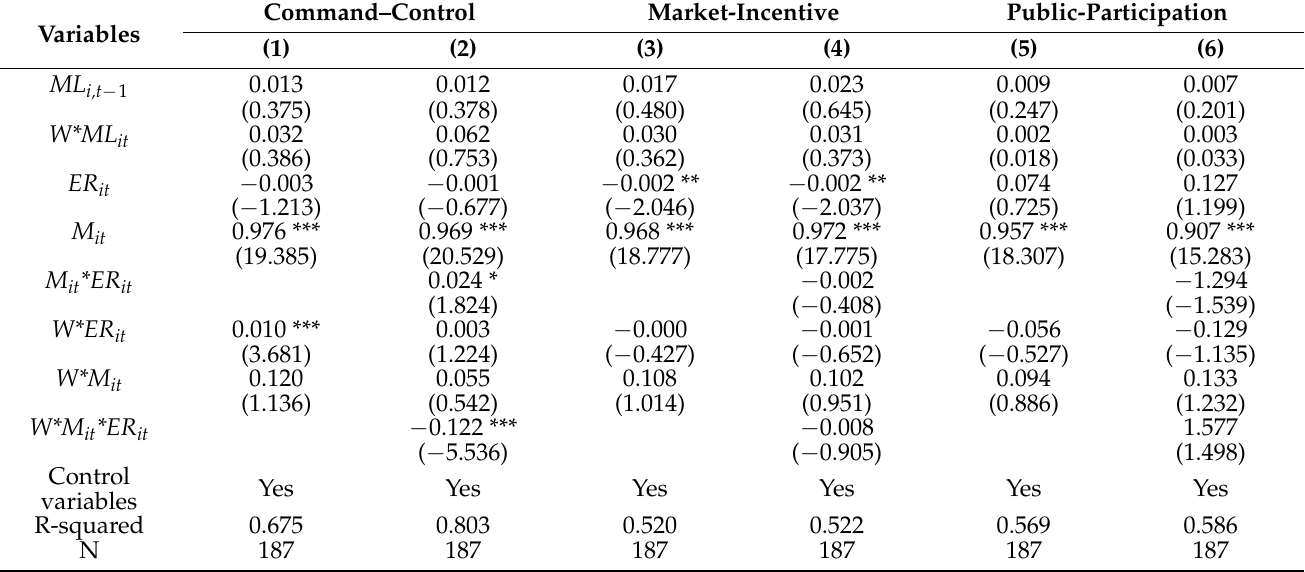
Table 8. The moderating results of technical change in the eastern region.